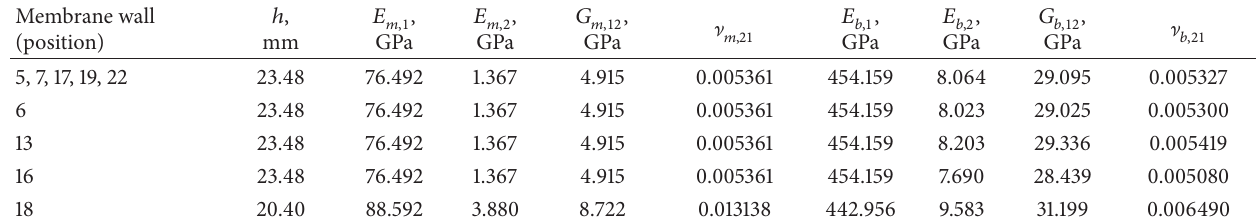
Table 3: Elasticity constants and wall thickness of equivalent orthotropic plate for membrane walls of “Milano” boiler. Membrane wall